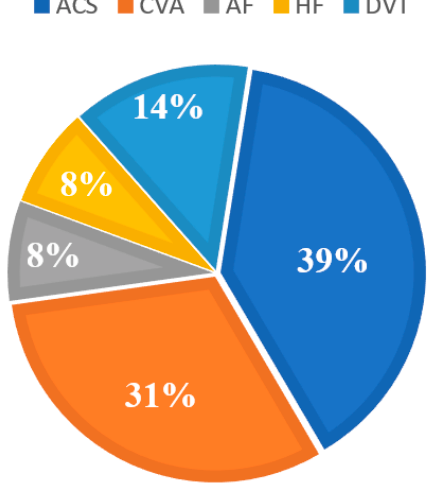
Figure 1. A chart of the five CVDs